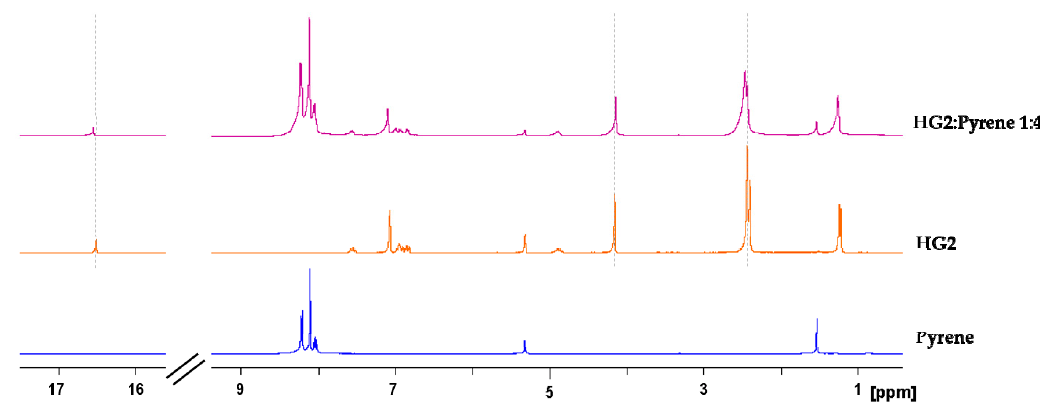
Figure 2. 1 H NMR of pyrene, HG2 and HG2:pyrene at 1:4 molar ratio. TMS scale.